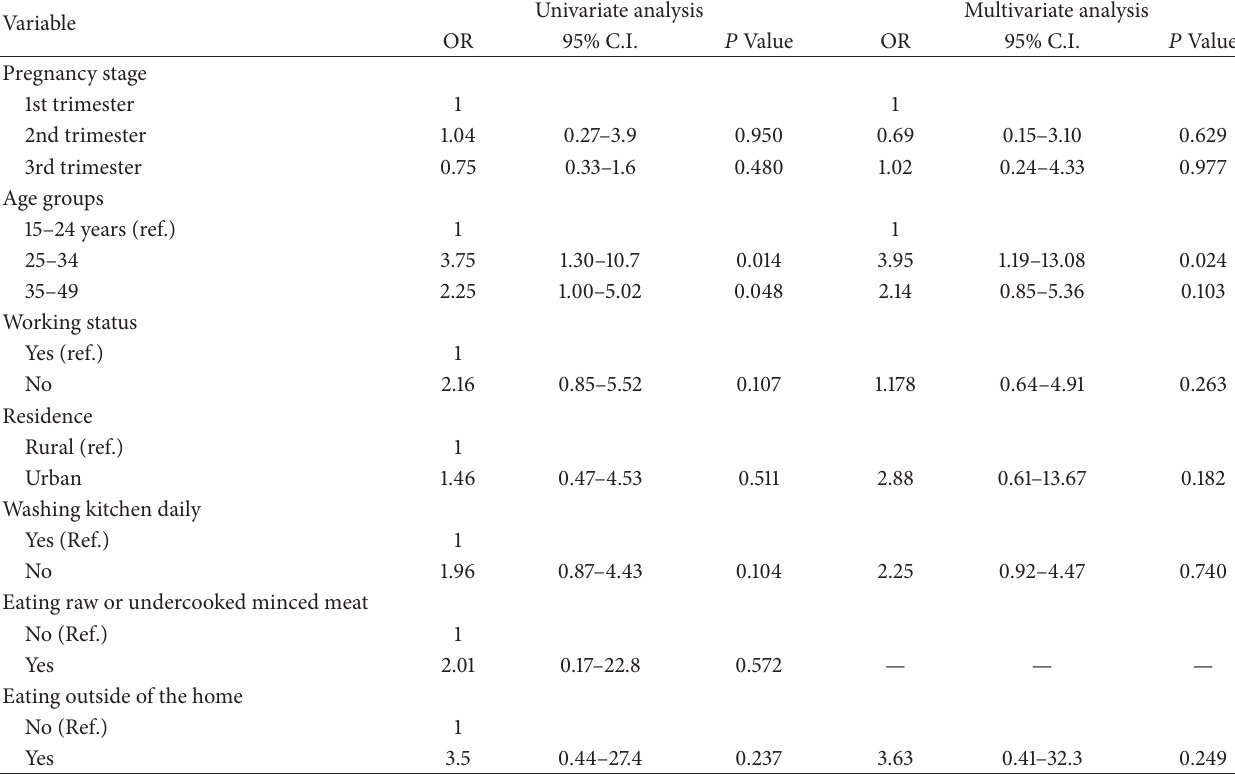
Table 2: Results of multivariate logistic regression analysis of IgG related